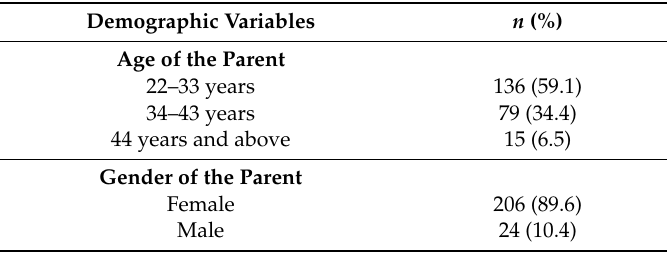
Table 1. Sociodemographic profile of the parents and their preschool